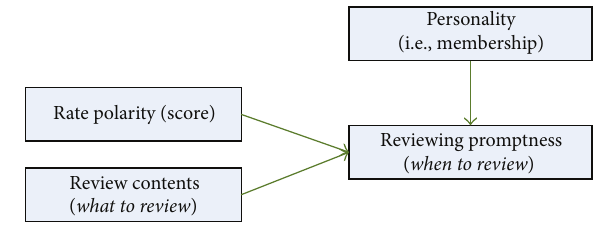
Figure 3: The theoretical